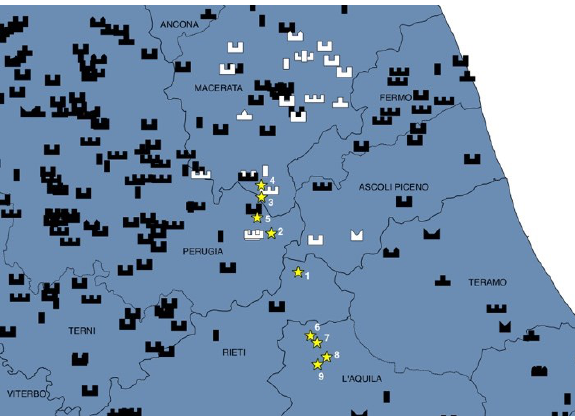
Figure 3. Map of Central Italy with the fortified buildings represented with symbols for the different typologies. The damaged buildings are coloured in white.